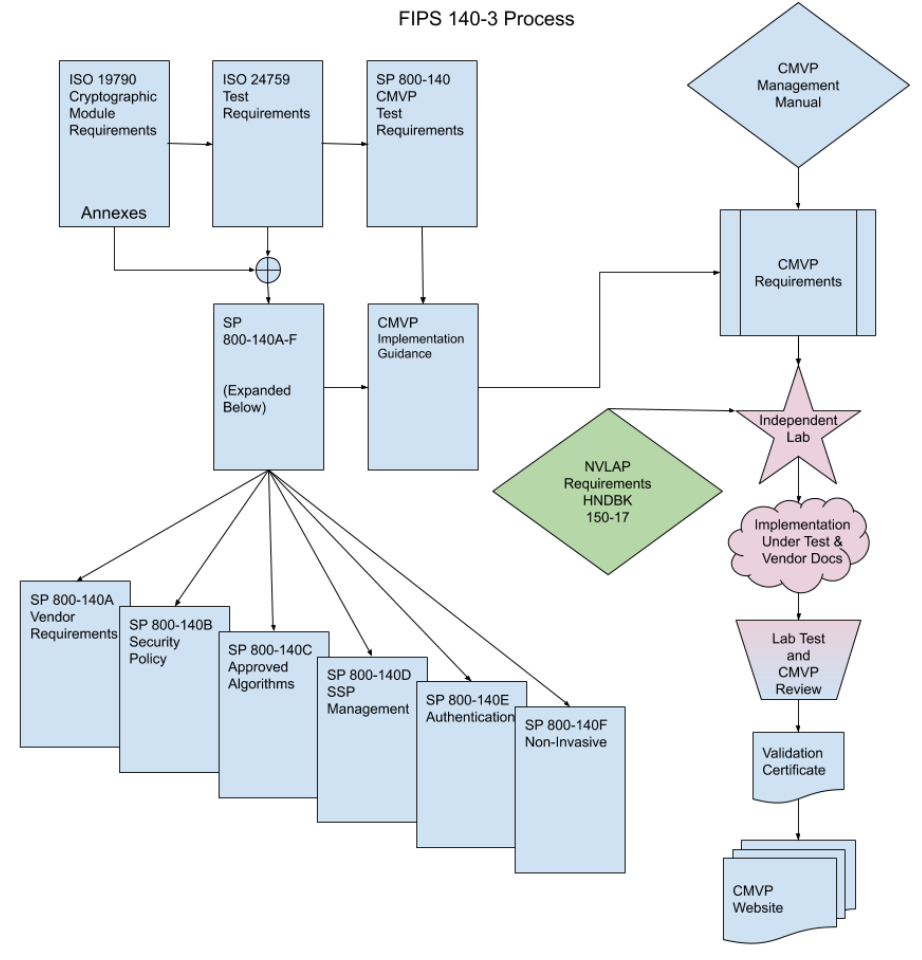
Figure 1. FIPS 140-3 process flow